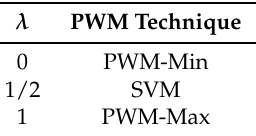
Table A1. Operation modes of the generalised pulse width modulation